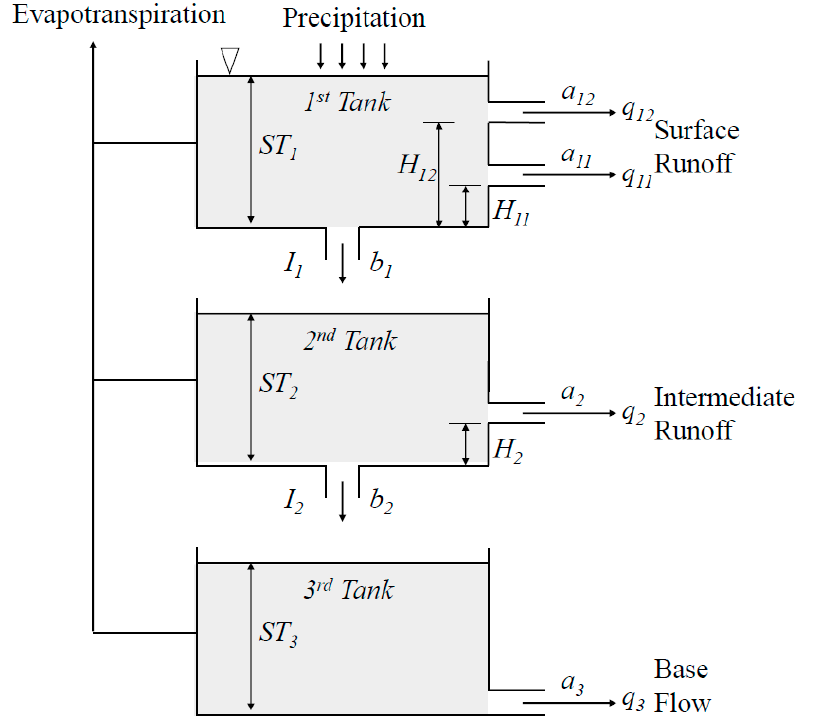
Figure 2. Schematic diagram showing the structure of the 3-tank model.